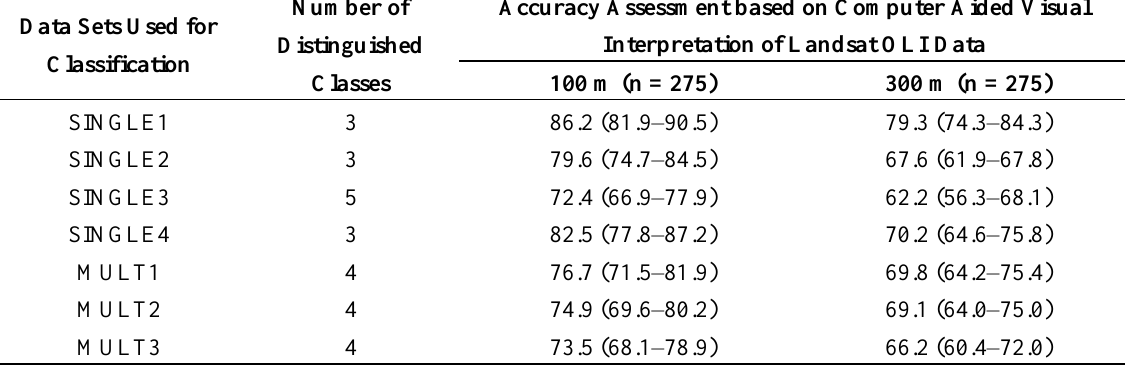
Table 5. Overall accuracy for the supervised MLC. Confidence intervals at the 5% significance level are shown in parentheses [39,40]. All differences between 100 and 300 m are statistically significant at the 0.05 probability